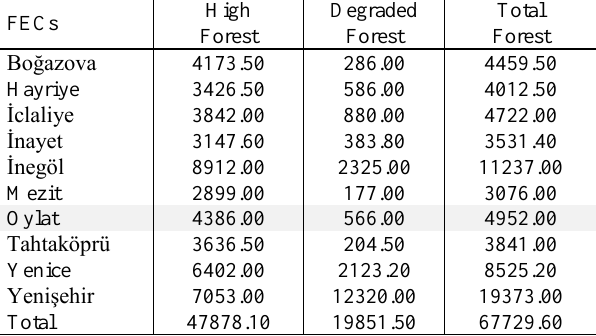
Table 1.Forest resources in İnegöl FED (ha)